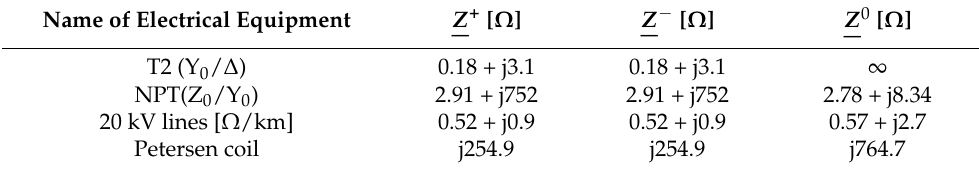
Table 1. The values of the sequence impedances of the elements in the scheme shown in Figure 1.